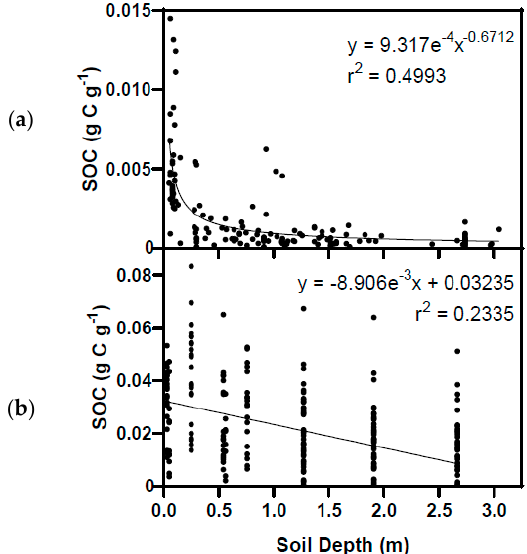
Figure 5. Soil organic carbon concentration with depth from SRS environmental samples collected and reported for ( a ) upland soils [44] and ( b ) wetland soils [45] .